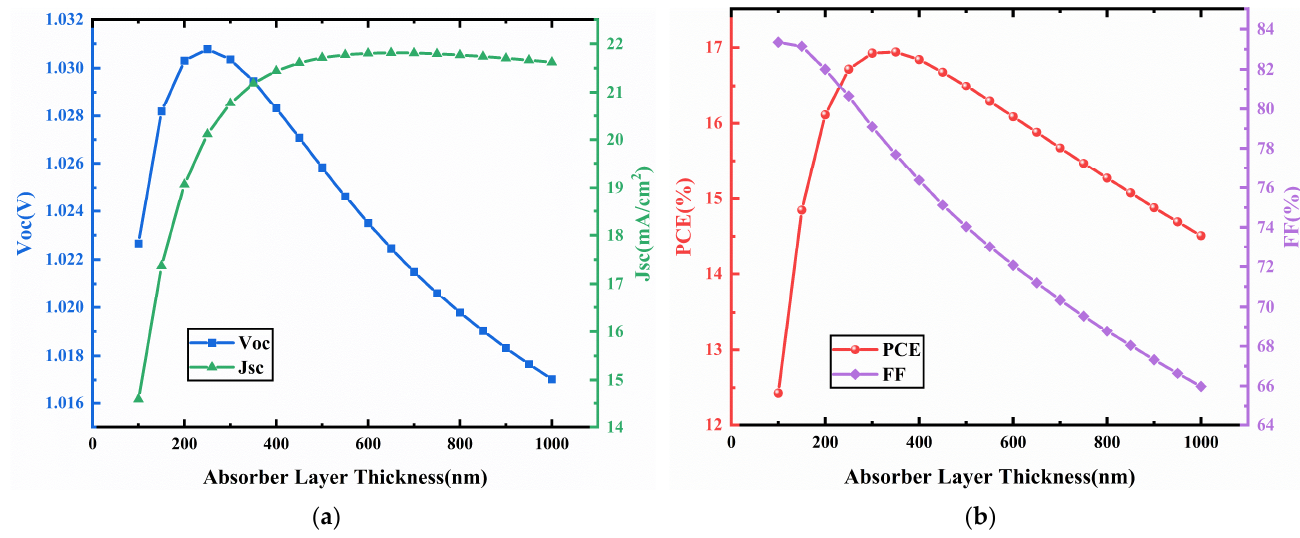
Figure 6. ( a ) Change in Voc and Jsc against CCSCNC absorber layer thickness variation; ( b ) change in PCE and FF against CCSCNC absorber layer thickness variation.